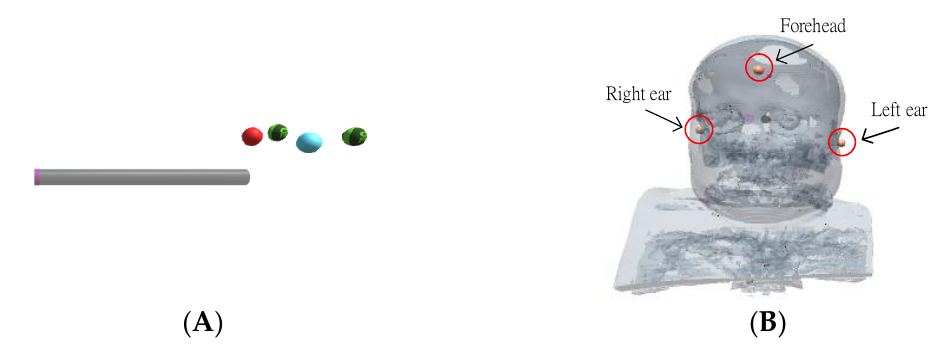
Figure 2. 4-marker scalpel model and AR scalp model and markers. ( A ) 4-marker scalpel model. ( B ) AR scalp model and markers.